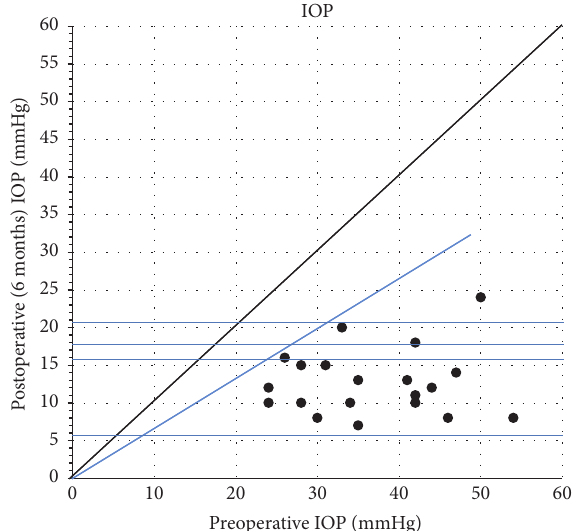
Figure 2: Average IOP preoperatively versus six months postoper-